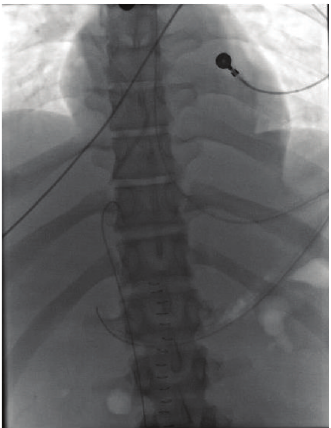
Figure 4: Chest X-ray AP view showing catheter projected over right atrium and superior IVC.